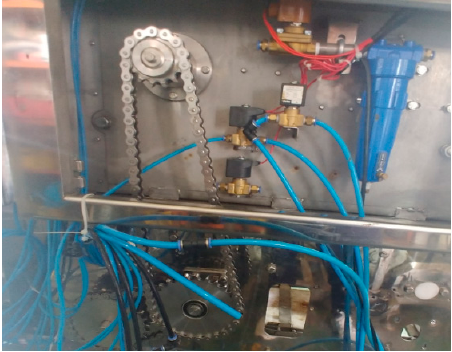
Figure 1. Conventional driving method of the SBOGM.